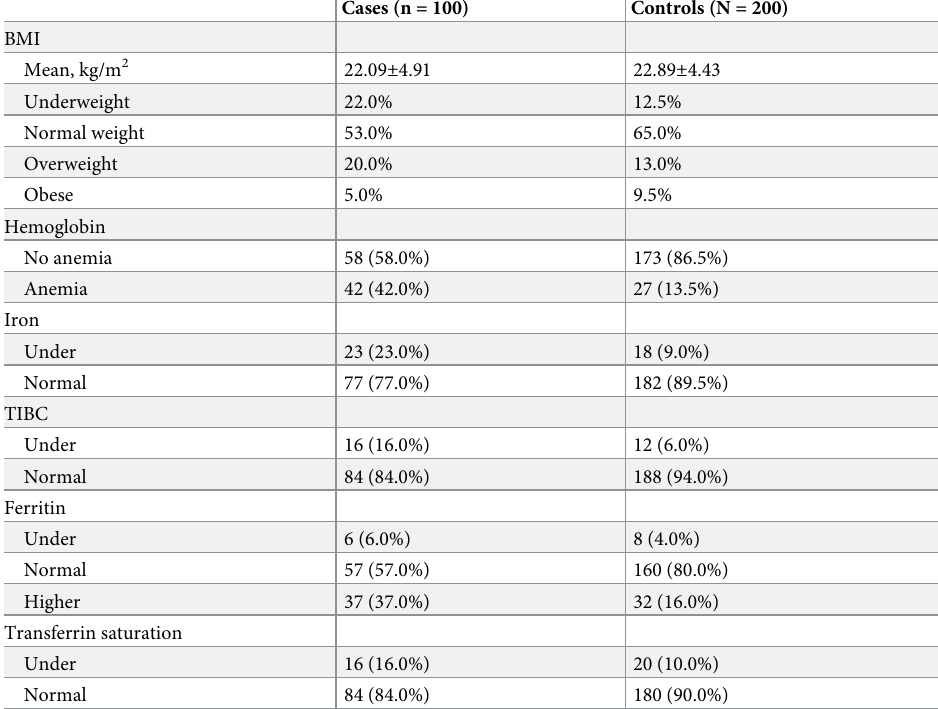
Table 3. Body mass index, anemia and iron